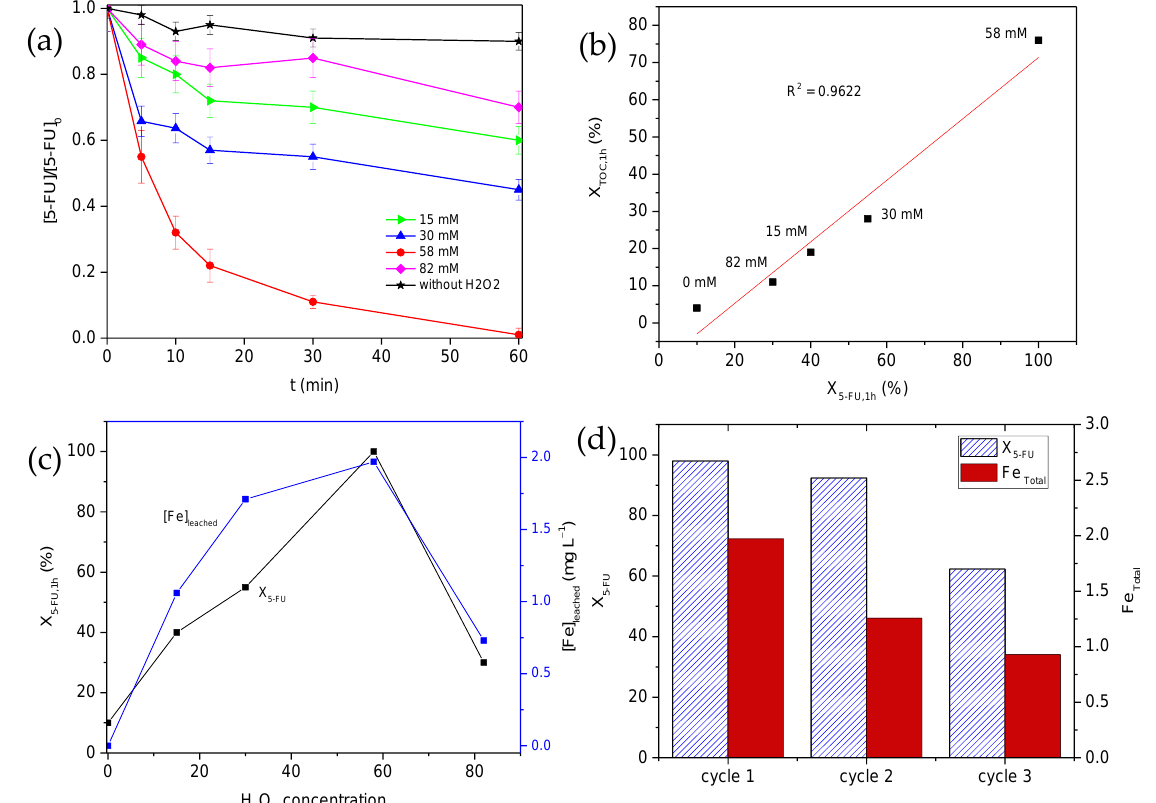
Figure 7. ( a ) Effects of the H 2 O 2 concentration on the 5-FU degradation under simulated solar radiation; ( b ) correlation between the 5-FU conversion (X 5-FU ) and the mineralization degree achieved in 60 min; ( c ) relationship between X 5-FU and Fe-leaching with the H 2 O 2 concentration (pH = 3.0 and 100 mg L − 1 Fe 3 O 4 ); and ( d ) X 5-FU and iron leached with the catalyst reusability during three consecutive cycles.